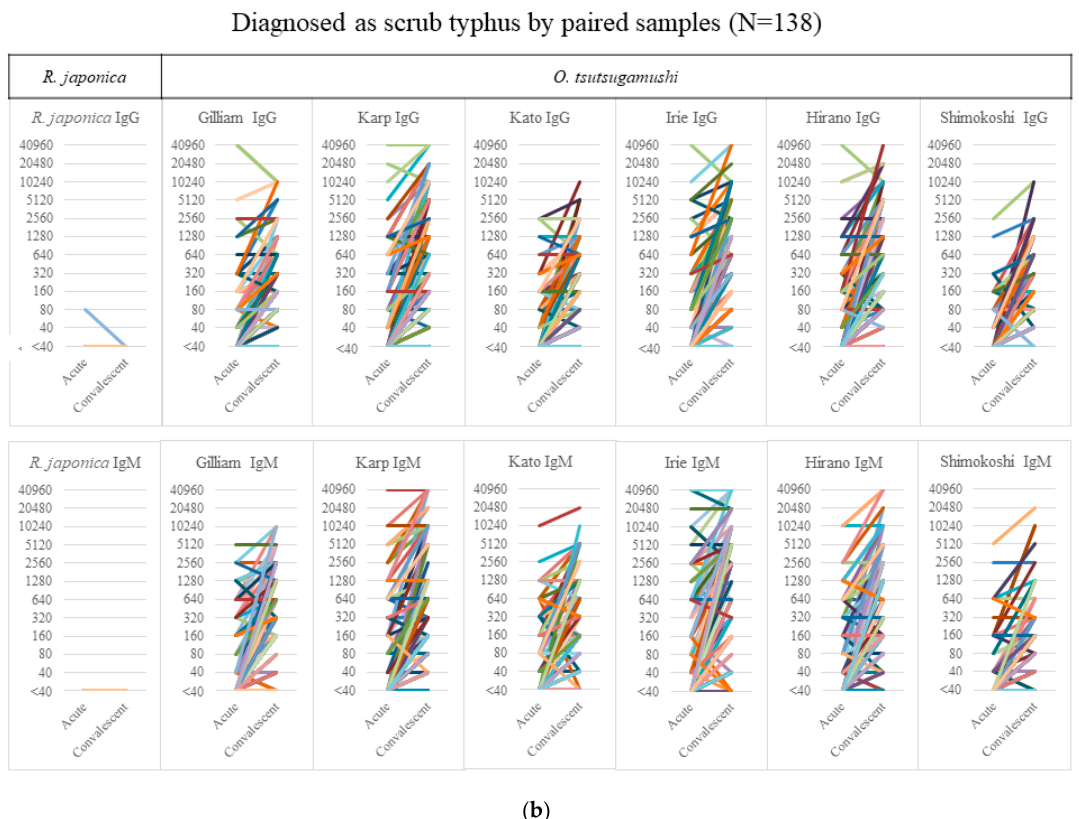
Figure 1. Serology results of cases of IgM/IgG against R. japonica and O. tsutsugamushi. The titer of IgM/IgG against R. japonica and the maximum titer of 6 serotypes against O. tsutsugamushi in Japanese spotted fever ( a ) and scrub typhus ( b ) are shown in acute and convalescent-phase samples. Abbreviations: Irie, Irie/Kawasaki; Hirano, Hirano/Kuroki.